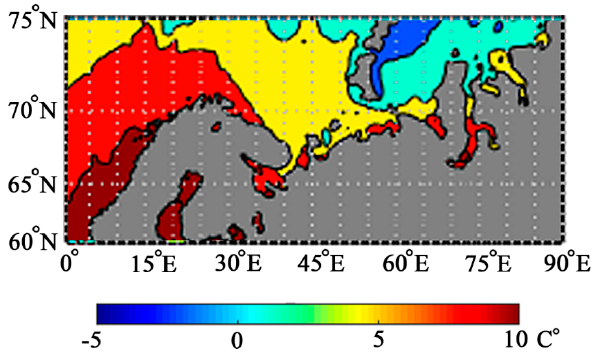
Figure 6. Observed SST field on July 15, 2013.